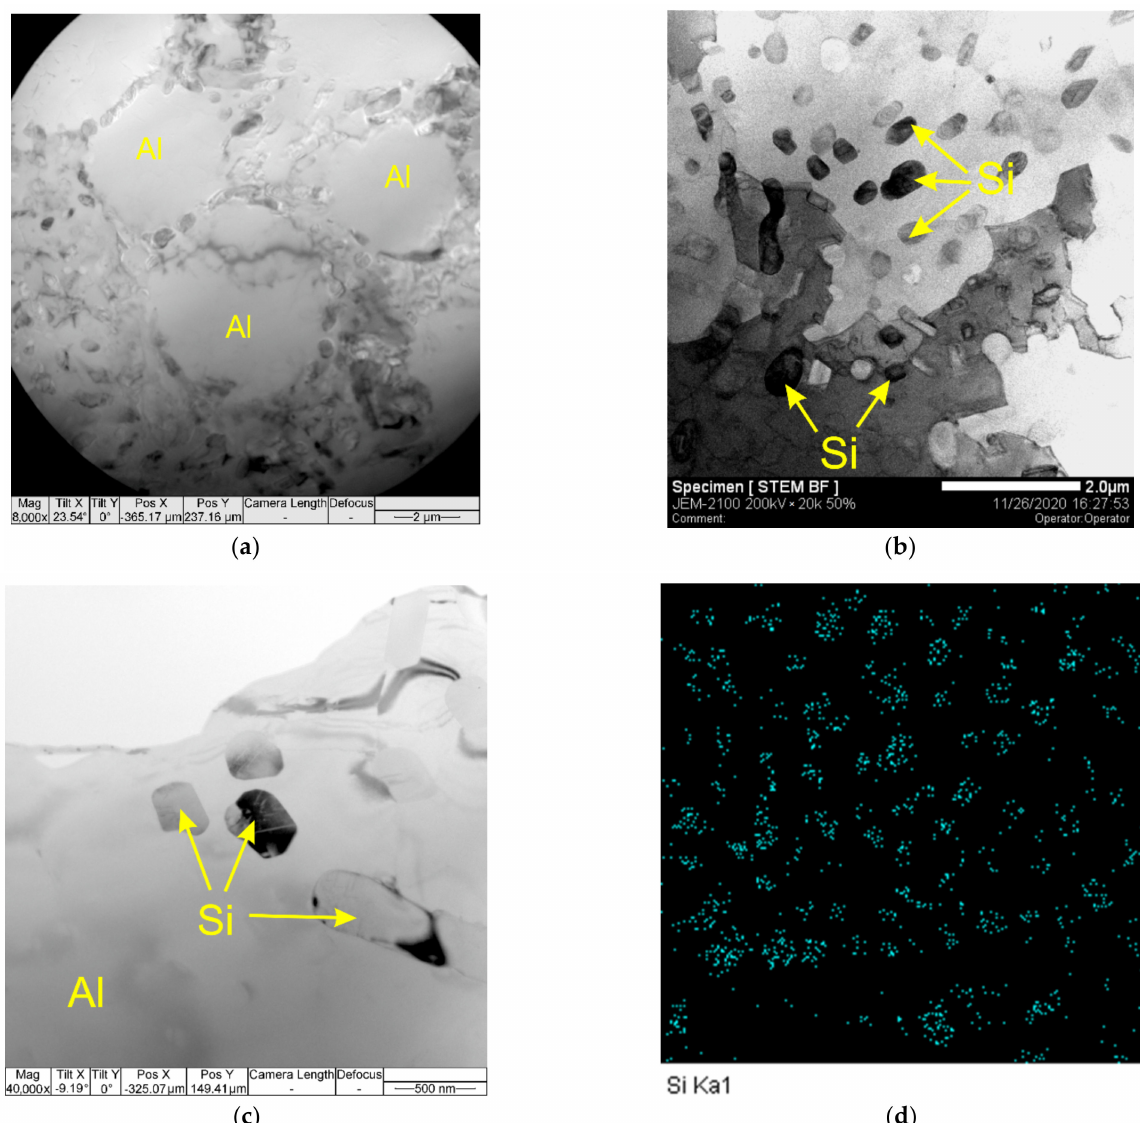
Figure 11. Small α -Al grains with a necklace of Al/Si eutectics ( a ), ( b ) Al/Si eutectic region, ( c ) Si crystallites inside the α -Al grains and ( d ) EDS map of Si distribution corresponding to ( b